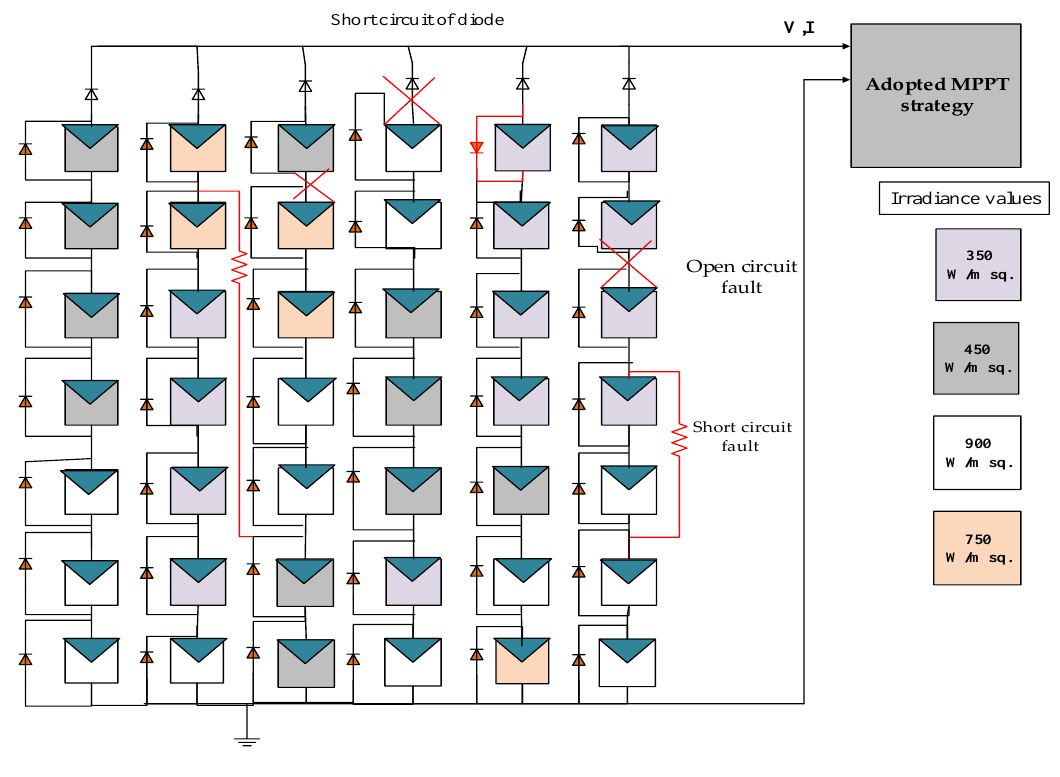
Figure 3. Considered faults in a PV array.